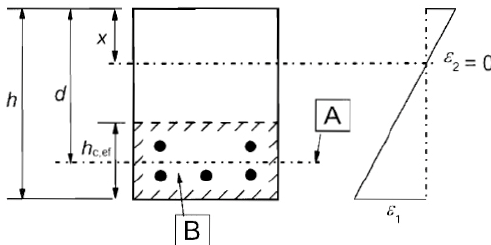
Figure 4. Effective height, h c,eff according to Eurocode 2 [13]. A , level of steel centroid; B , effective tensioned area A c,eff .